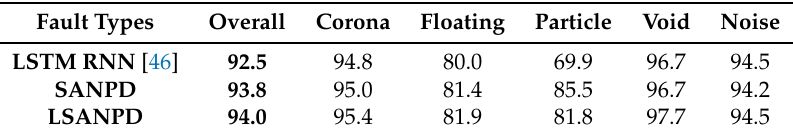
Table 4. Performance comparisons in terms of accuracy.